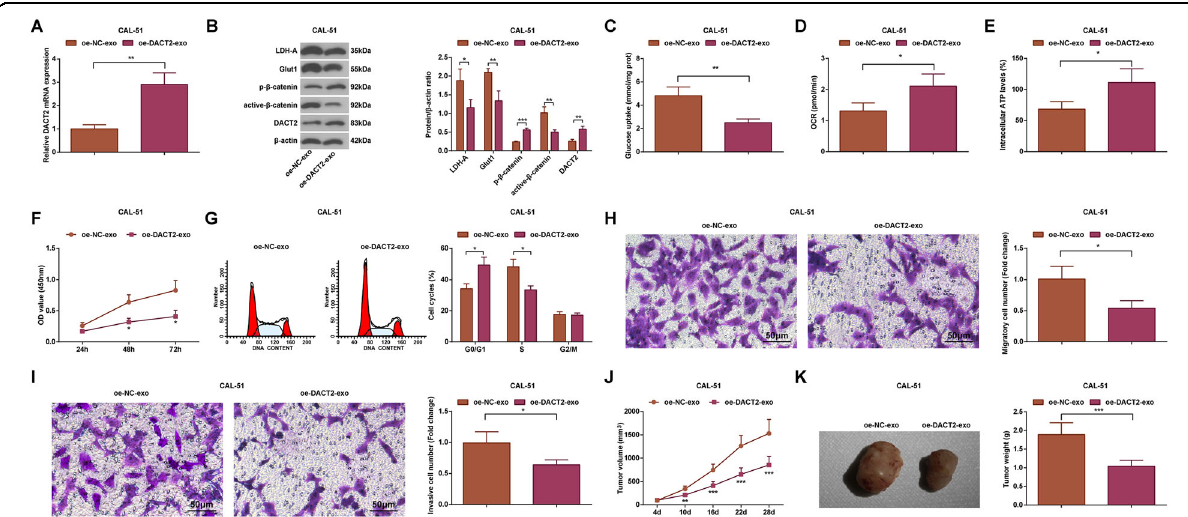
Fig. 6 Upregulated DACT2 inactivates the Wnt/ β -catenin signaling pathway, restrains glycolysis, and elevates mitochondrial OXPHOS in CAL-51 cells. A RT-qPCR measured miR-503-3p and DACT2 expression in CAL-51 cells; B western blot analyzed DACT2, active- β -catenin, p- β -catenin, Glut1, and LDH-A protein expression in CAL-51 cells; C glucose intake of CAL-51 cells; D oxygen consumption rate of CAL-51 cells; E ATP level in CAL- 51 cells; F CAL-51 cell viability; G fl ow cytometry determined cell cycle distribution; H , I Transwell assay tested migration and invasion ability of CAL- 51 cells; J , K tumor volume and weight of nude mice that had been injected with CAL-51 cells; repetitions = 3 in ( A – I ), n = 6 in ( J , K ); * P < 0.05; ** P < 0.01; *** P < 0.001; the measurement data conforming to the normal distribution were expressed as mean ± standard deviation and data of groups were compared using Student ’ s t